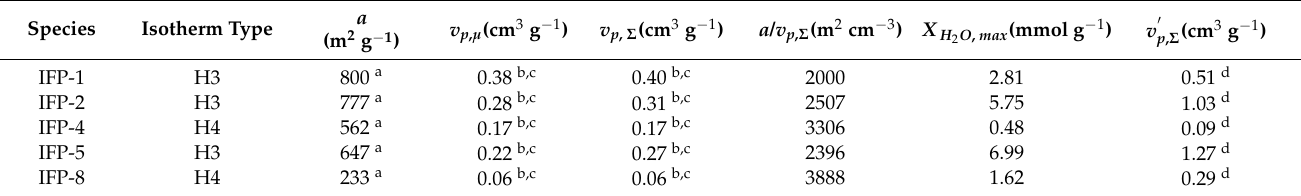
Table 2. Overview of the characteristic data of the tested IFP samples gained from isotherms with N 2 , CO 2 and water vapor: Specific surface ( a ), micro pore volume ( v p , µ ), overall pore volume ( v p , Σ ), specific surface to pore volume ratio ( a / v p ), maximum uptake of water vapor at T = 303.15 K ( X H ) and total pore volume derived from maximum uptake of water 2 O , max vapor ( v (cid:48) p , Σ